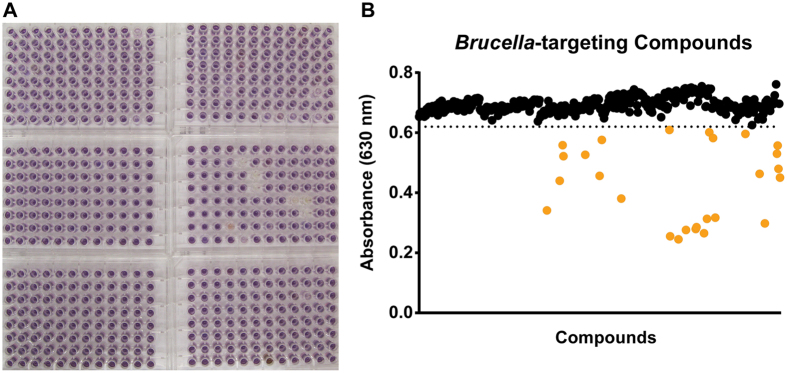
Screen for molecules that inhibit Brucella abortus metabolism in vitro.(A) A panel of six 96-well plates arrayed with 480 small molecules from the ICCB bioactives library. B. abortus growth/metabolism was assessed colorimetrically in test and control wells containing a minimal-defined base medium and tetrazolium dye as a metabolic indicator (purple color, monitored at 630 nm) as described in Methods. (B) B. abortus metabolism in minimal-defined medium in the presence of 480 ICCB compounds, as assessed by quantifying tetrazolium formazan absorbance at 630 nm. Orange circles represent twenty-six compounds that inhibited Brucella metabolism by ≥1 standard deviation from the mean (dotted horizontal line represents 1 standard deviation below the mean). ICCB compounds are plotted sequentially along the x-axis. The twenty-six hit compounds are listed in Table 1.